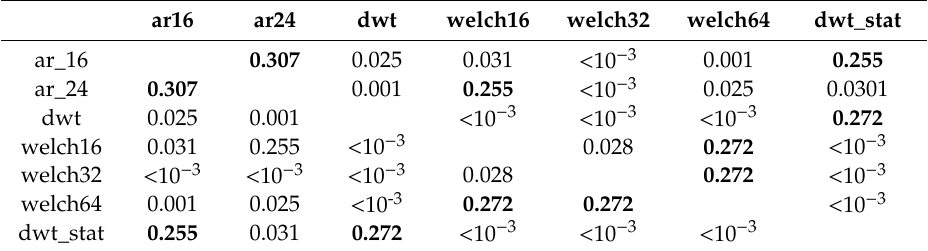
Table 23. Result of the Dunn post hoc test in the form of the p -value matrix. Values indicating no statistically significant values are marked in bold font.